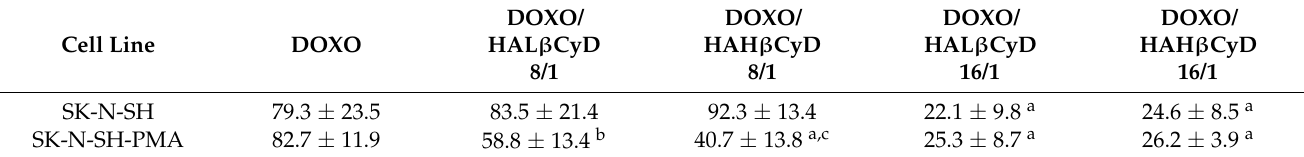
Table 2. Antiproliferative activity (IC 50 , nM) of DOXO and CyD polymers in SK-N-SH and PMA stimulated SK-N-SH-PMA